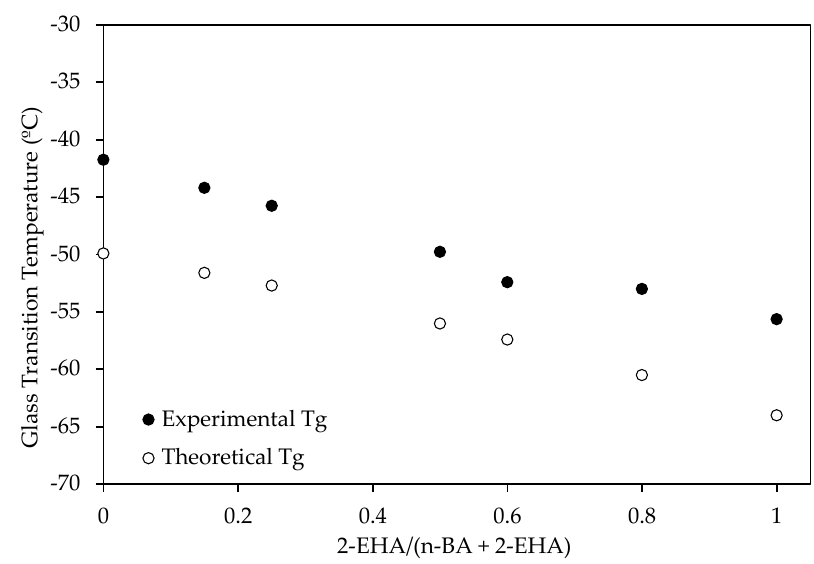
Figure 6. Influence of co-monomer ratio on the T g values.